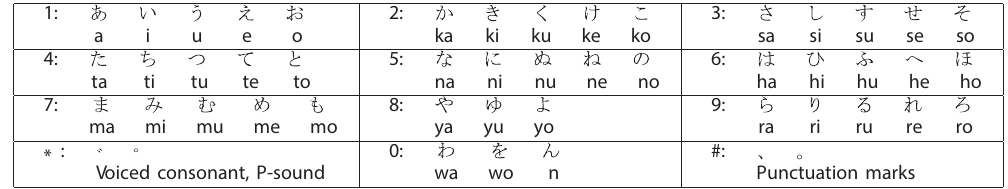
Figure 1: Correspondance of number to KANA and its pronunciation.